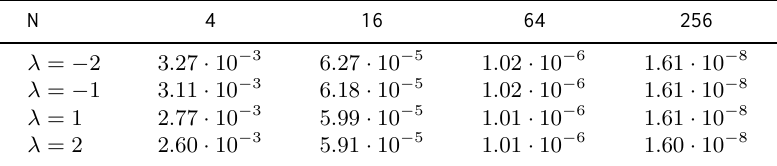
y ( s ) ds + f ( t ) , nonlocal method. 0